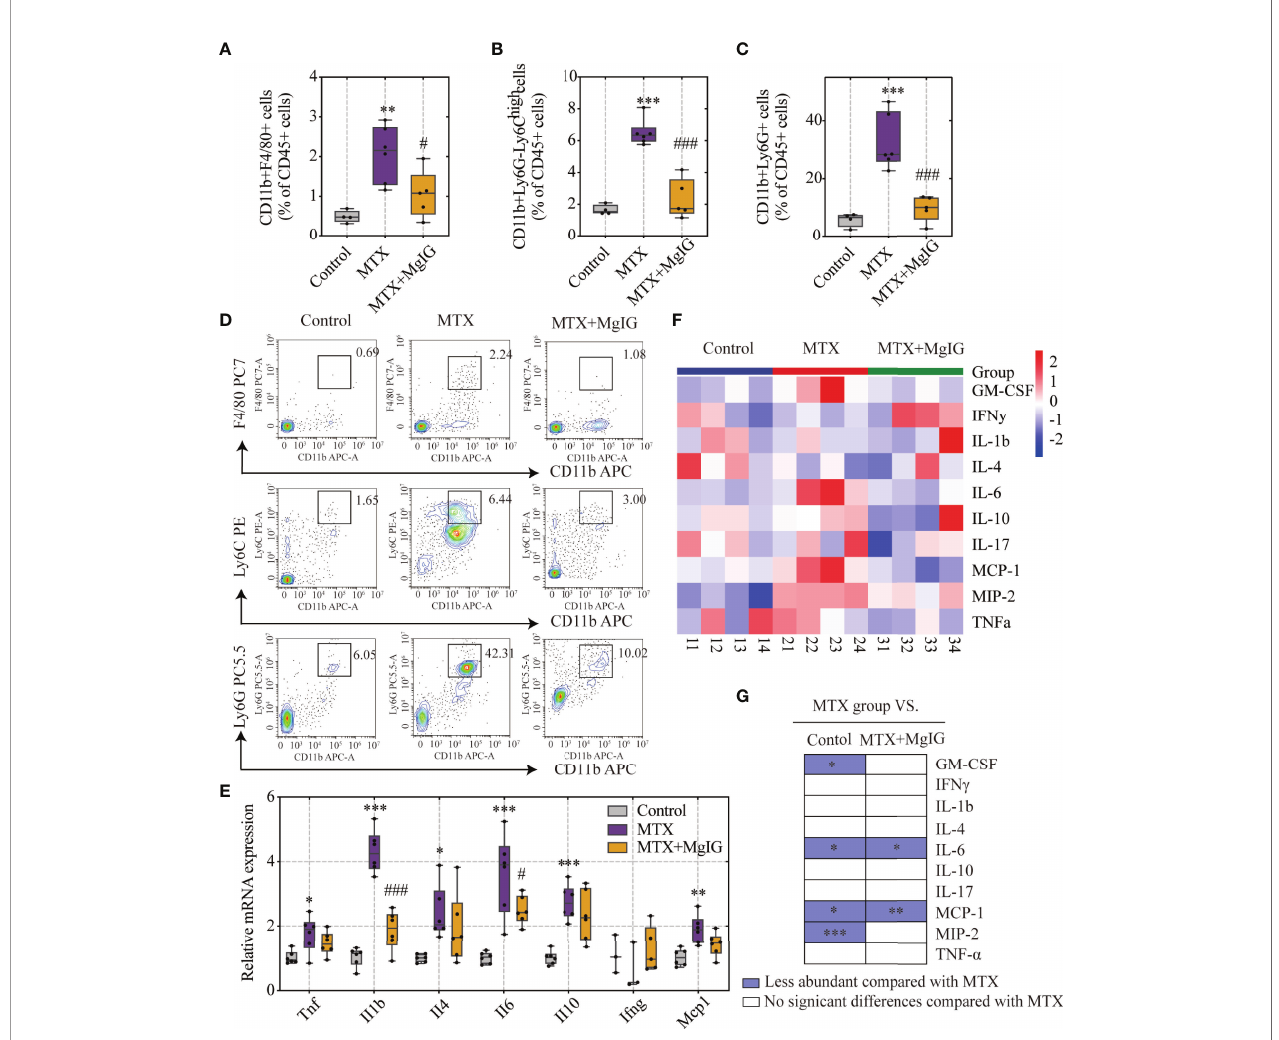
FIGURE 2 | MgIG reduced MTX-induced in fl ammation levels. (A – D) FACS staining of immune cells (neutrophils, monocytes and macrophages) in the liver represented as percentages of CD45+ cells (n = 4-6, One-way ANOVA). (E) Relative mRNA expression of cytokines in liver tissues from each group (n = 3-6). (F) Heatmap of speci fi c cytokine and chemokine levels in serum, including IFN- g , IL-4, IL-6, GM-CSF, IL-1 b , IL-17, IL-10, TNF- a , MIP-2, MCP-1 (n = 4). (G) Cytokines and chemokines from panel F and comparisons of MTX and other groups. Purple entries indicate cytokines/chemokines that were less abundant in various groups compared to the MTX group. *p < 0.05, **p < 0.01, ***p < 0.001, compared with Control group. # p < 0.05, ### p < 0.001, compared with MTX group. ALT, alanine aminotransferase; AST, aspartate